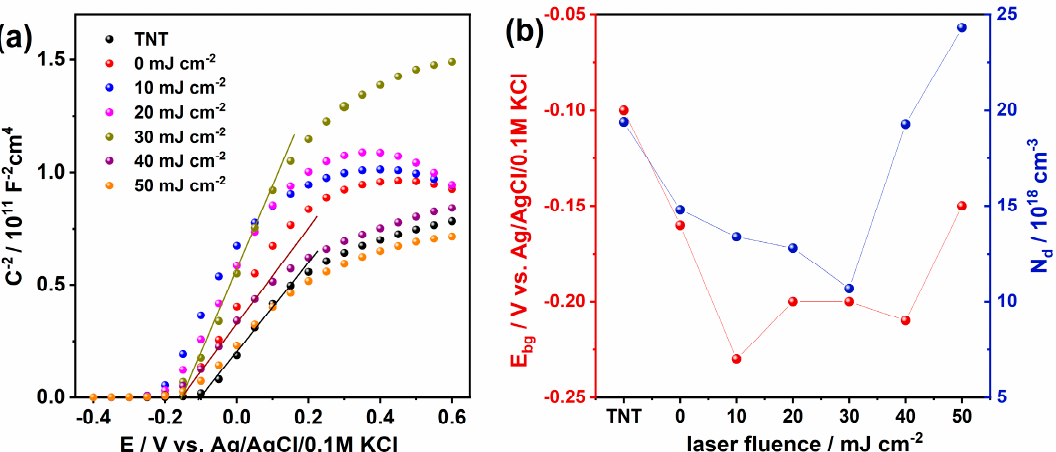
Figure 7. ( a ) Mott–Schottky plot of bare and modified titania in 0.5 M Na 2 SO 4 solution. ( b ) The change in band gap energy (E bg ) position and donor density depending on the applied laser fluence. The values of those parameters were determined on the basis of the Mott–Schottky plot given in ( a ). The flat band potential for pure titania is localized at − 0.1 V vs. Ag/AgCl/0.1M KCl,